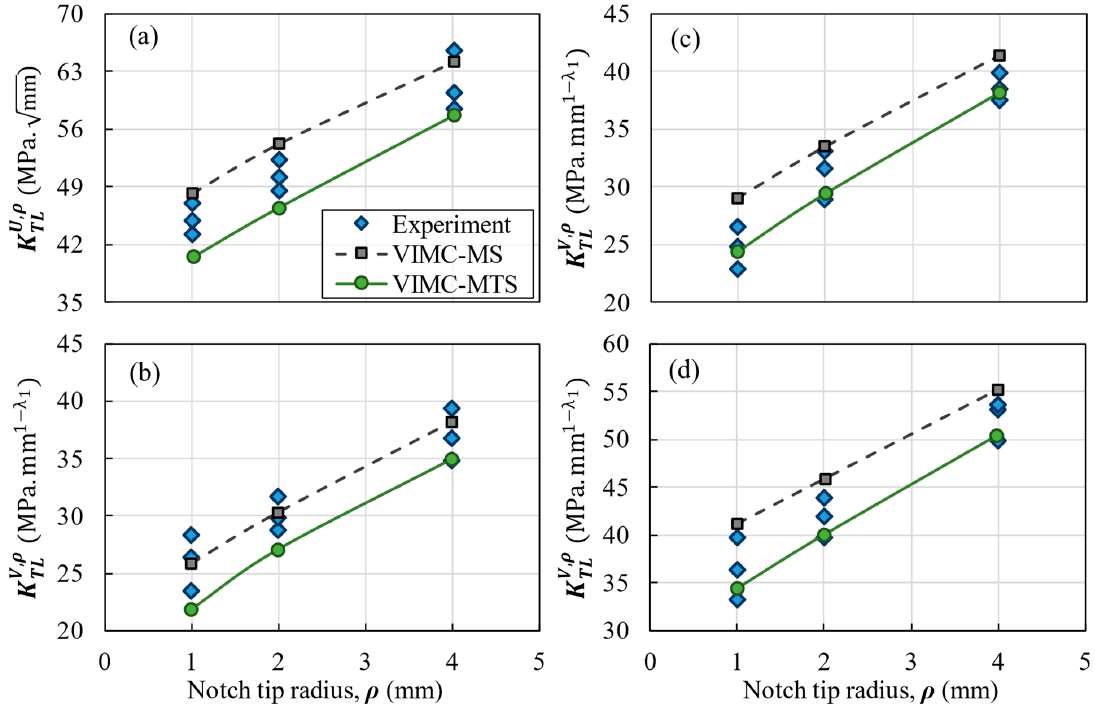
Figure 7. Experimental and predicted TLNFT of the unidirectional laminate versus the notch-tip radius. ( a ) U-notch; ( b ) V-notch with a 30° opening angle; ( c ) V-notch with a 60° opening angle; ( d ) V-notch with a 90° opening angle.